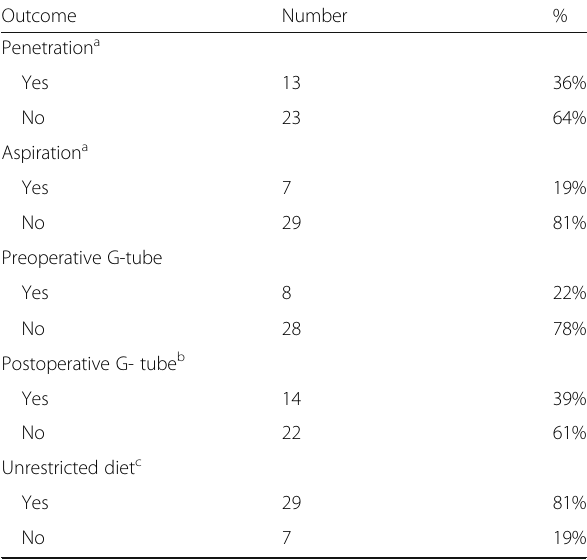
Table 3 Summary of swallowing outcomes based on clinical and videofluoroscopic assessment